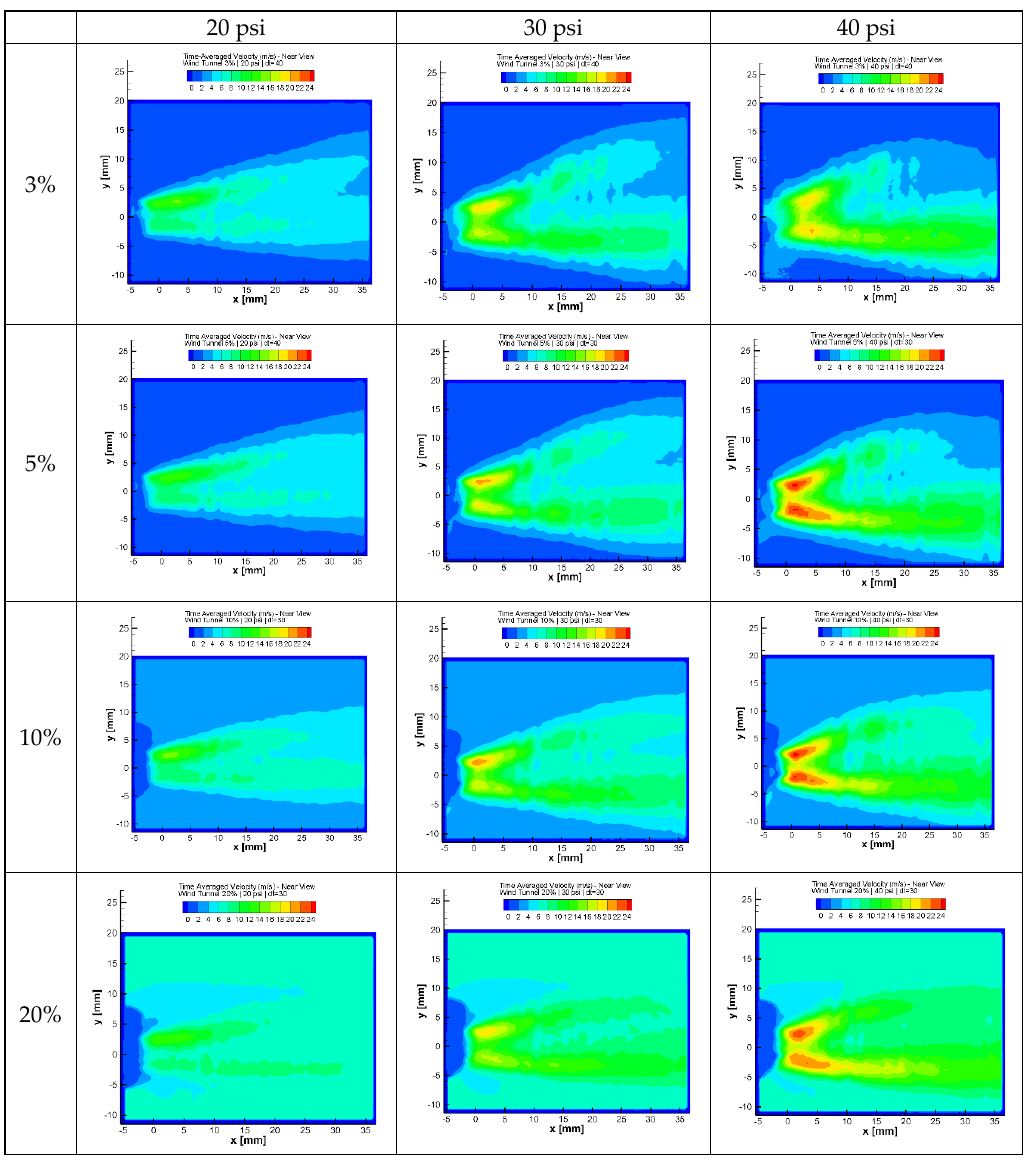
Figure 8. Time-averaged vortex-tube flow at near region. Data at 3%, 5%, 10%, and 20% freestream wind tunnel speed settings (rows) for three different vortex tube pressures (columns).